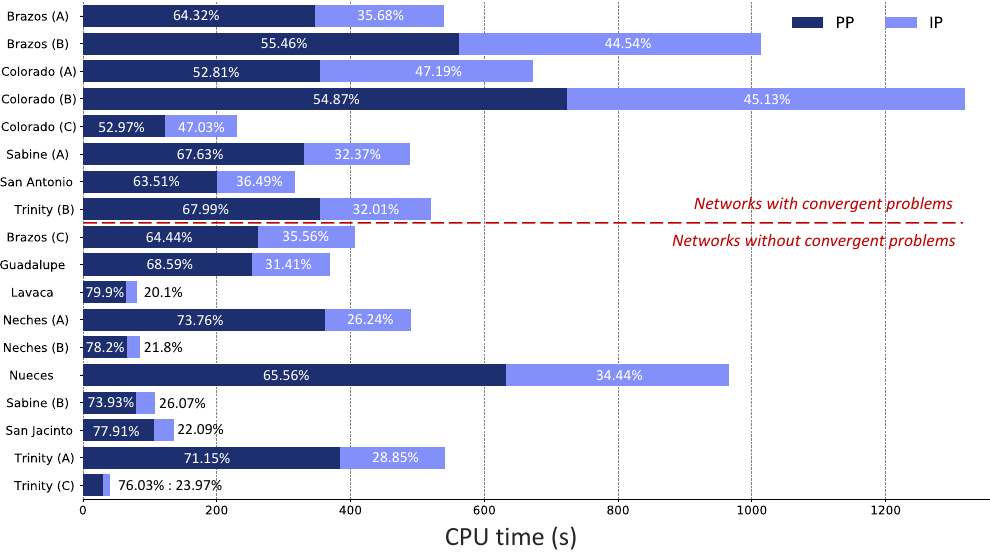
Figure 12. CPU time for executing the SSA algorithm in 18 river networks in the Texas–Gulf region. PP indicates SSA Preprocessor Procedure. IP indicates SSA Iteration